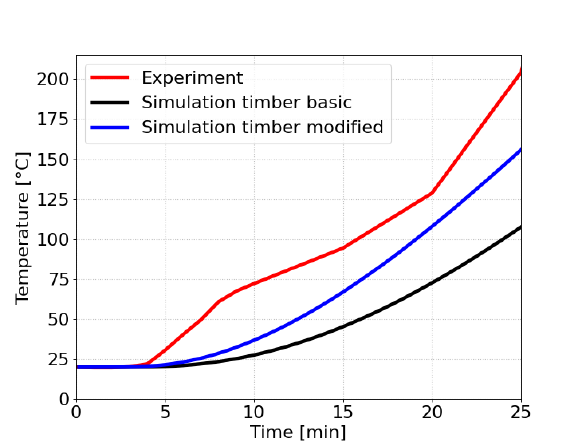
Figure 13. Comparison of experimental and simu- lated temperatures for beam protected with 22 mm OSB panels until the time when the protection fell off.